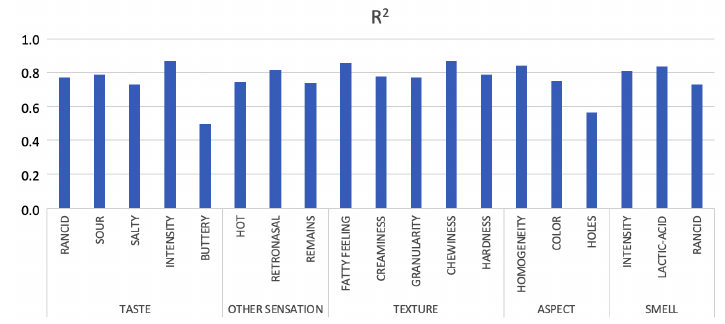
Figure 7. Squared correlation coefficient of prediction for the whole set of parameters for unknown